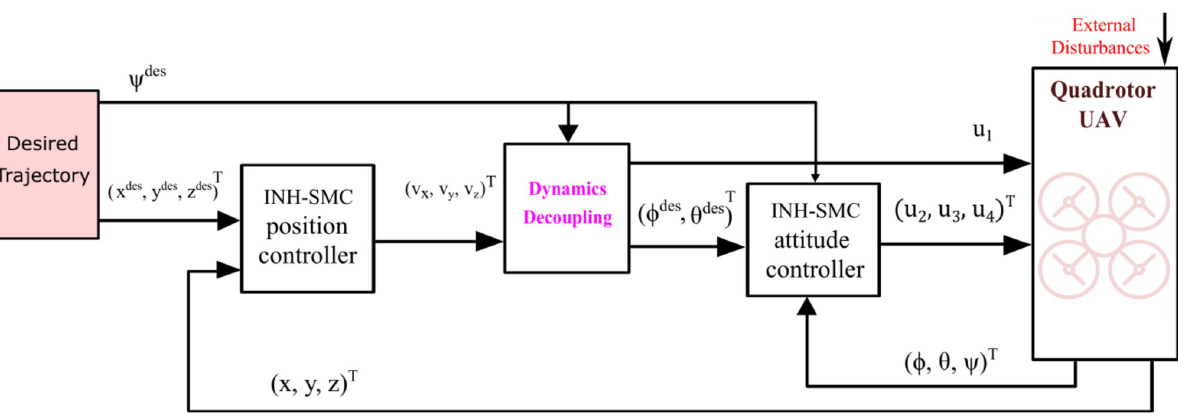
Fig 2. Structure block of the proposed control